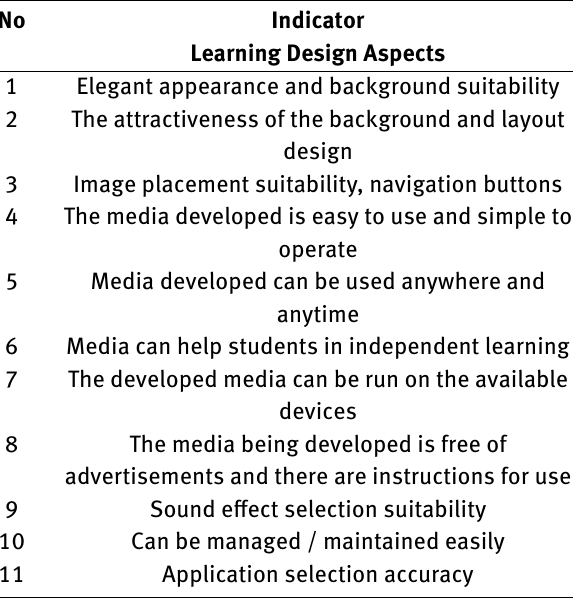
Table 1: The instrument for validation of the virtual laboratory